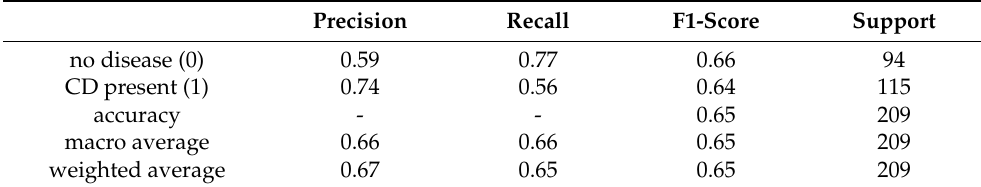
Table 7. Metrics for the CRP level-based model for CD prediction. Precision Recall F1-Score Support no disease (0)